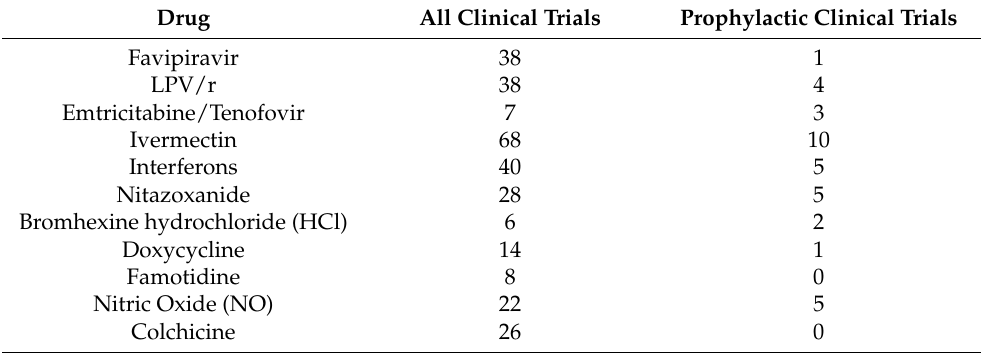
Table 1. Search outcomes summary.